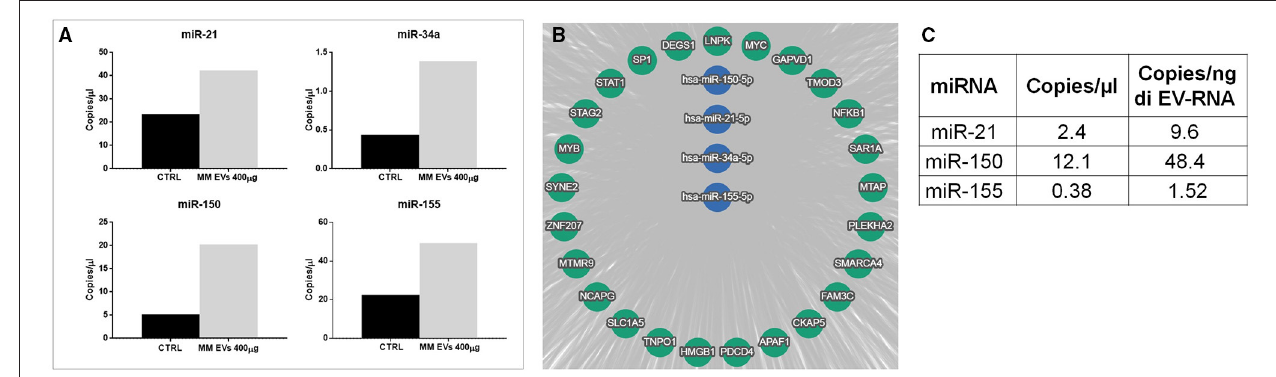
FIGURE 6 | miRNA alteration in HSPCs after MM-EV interaction. (A) Digital PCR analysis for miR-21, miR-34a, miR-150, and miR-155 on HSPCs treated and not with 400 µ g MM-derived EVs (the higher dose). (B) The target genes of hsa-miRNAs were analyzed by the bioinformatics tool miRTargetLink human. The central node represents miR-21, miR-34a, miR-150, and miR-155, and it was surrounded by the validated target with strong evidence. The bar graphs represent the average of three replicates. (C) The table showed miR-21, miR-150, and miR-155 amount as copies/ µ l of dPCR reaction mix and copies/ng of EV-RNA in EVs. MM, multiple myeloma; EVs , Extracellular vesicles; HSPC, hematopoietic stem and progenitor cells.